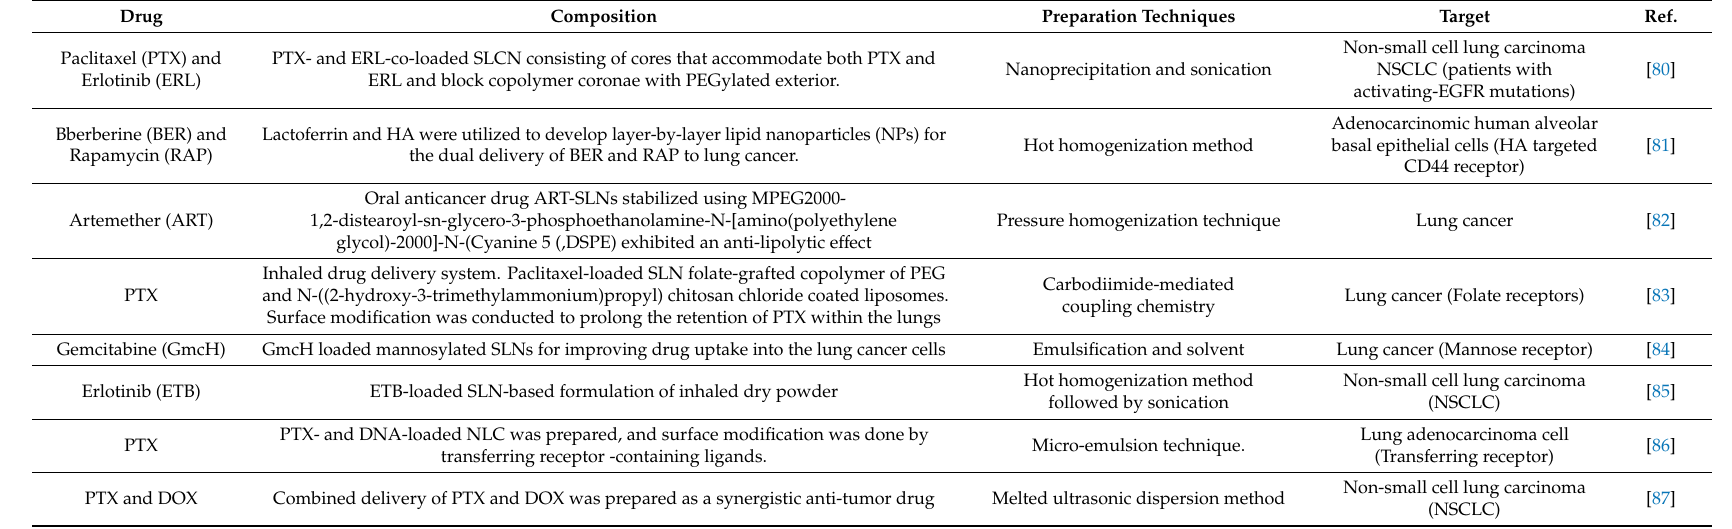
Table 2. SLNPs encapsulating di ff erent types of drugs for the treatment of lung